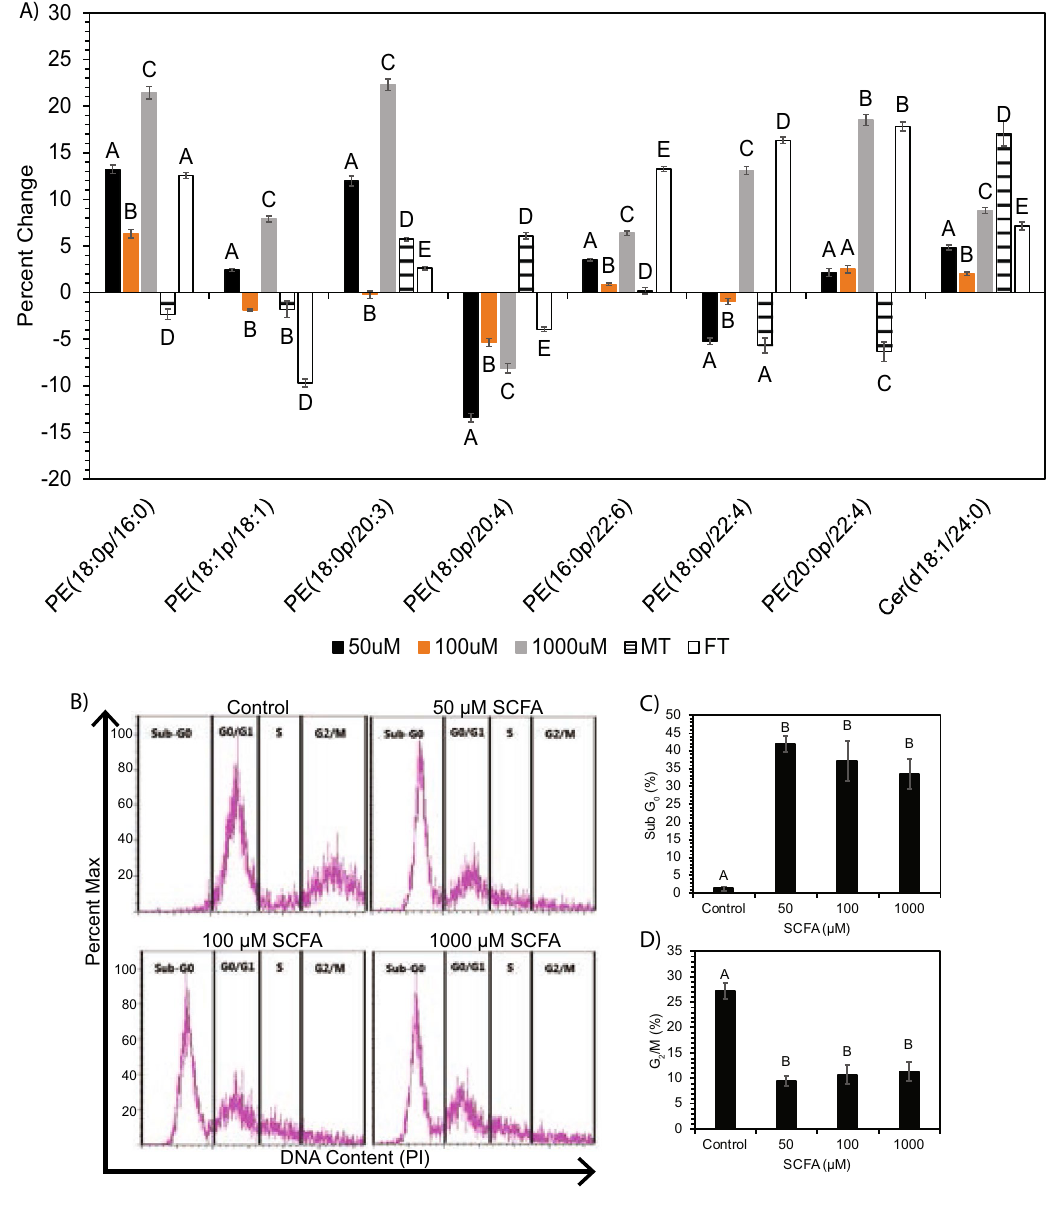
Figure 6. ( A ) Percent change of treatments vs respective controls for ANOVA significant (p < 0.05) plasmalogen and ceramide species altered in both neuronal cells and Long Evans rat brain. Significance was determined via ANOVA following PCA analysis for plasmalogen and ceramide in-vitro and in-vivo. Bar charts representative of mean ± standard error. Means represented by different superscripts are significantly different at p < 0.05. MT male rats treated with SCFAs, FT female rats treated with SCFAs. ( B–D ) SCFA treatment of neuronal cells causes increased apoptosis accompanied by loss of cells in G2/M. ( B ) Representative flow cytometry plots of propidium iodide (PI) staining of neuronal cells treated with control or 50–1000 μM SCFA. ( C ) Frequency of cells in sub- G0 (apoptotic) and ( D ) G2/M phases of the cell cycle. Bar charts representative of mean ± standard error. Means represented by different superscripts are significantly different at p <